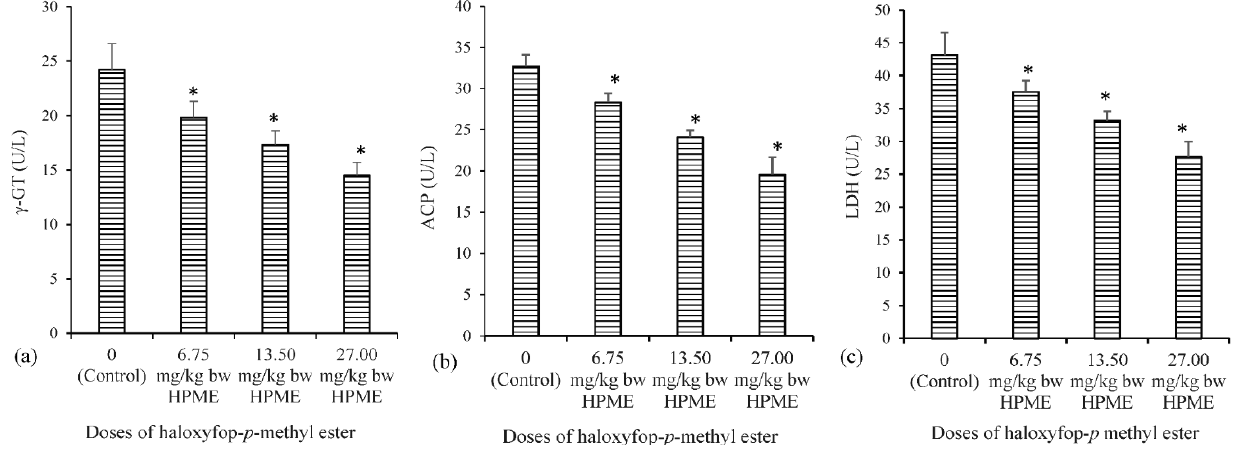
Figure 2. The influence of haloxyfop- p -methyl ester on biomarkers of testicular function